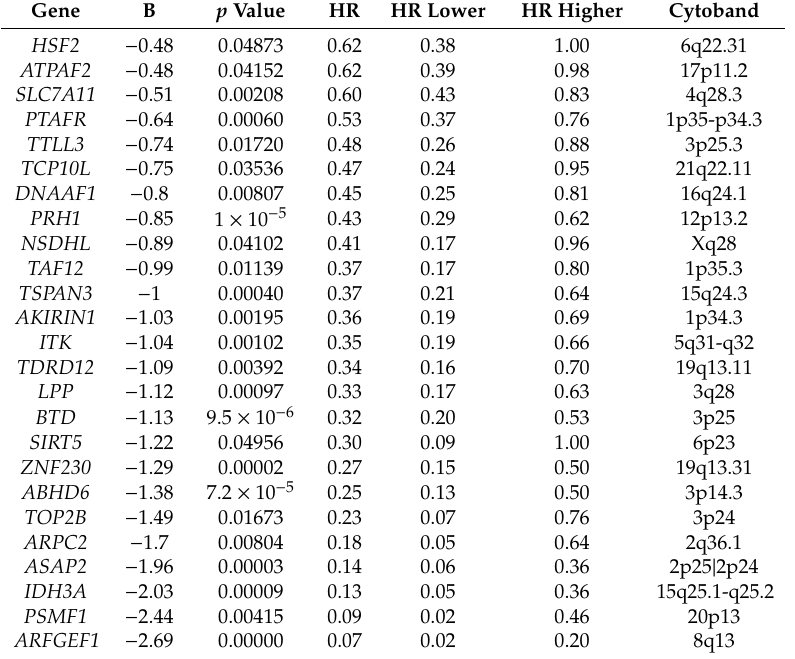
Table 6. Genes associated to good prognosis in the multivariate Cox survival analysis.